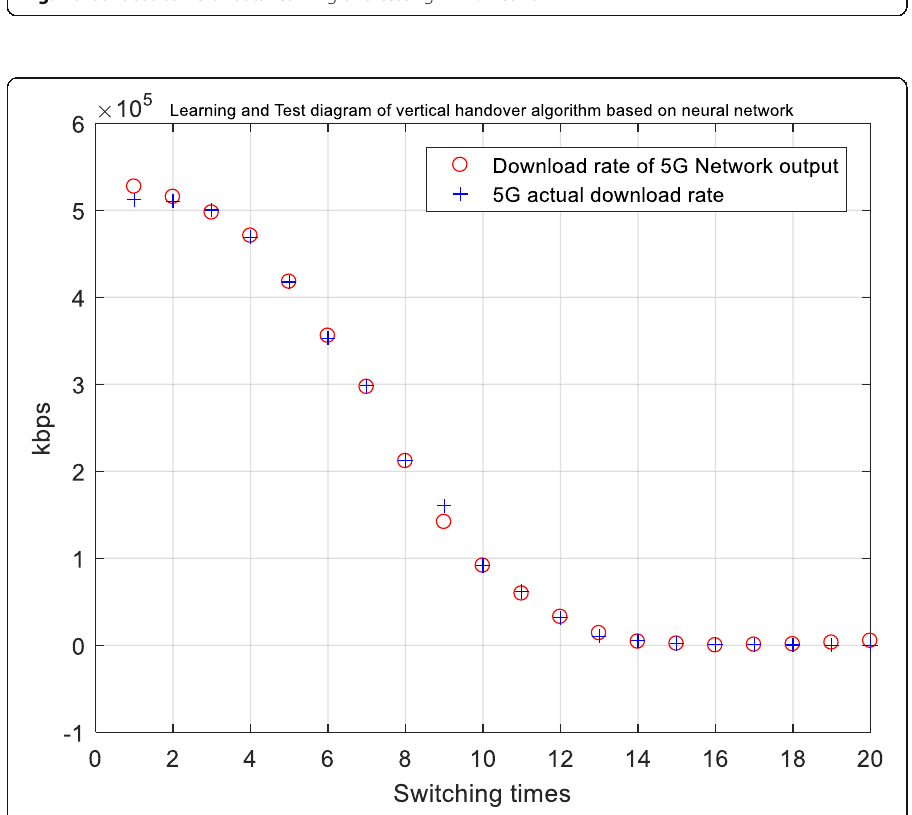
Fig. 11 Contrast curve of data learning and testing in 5G